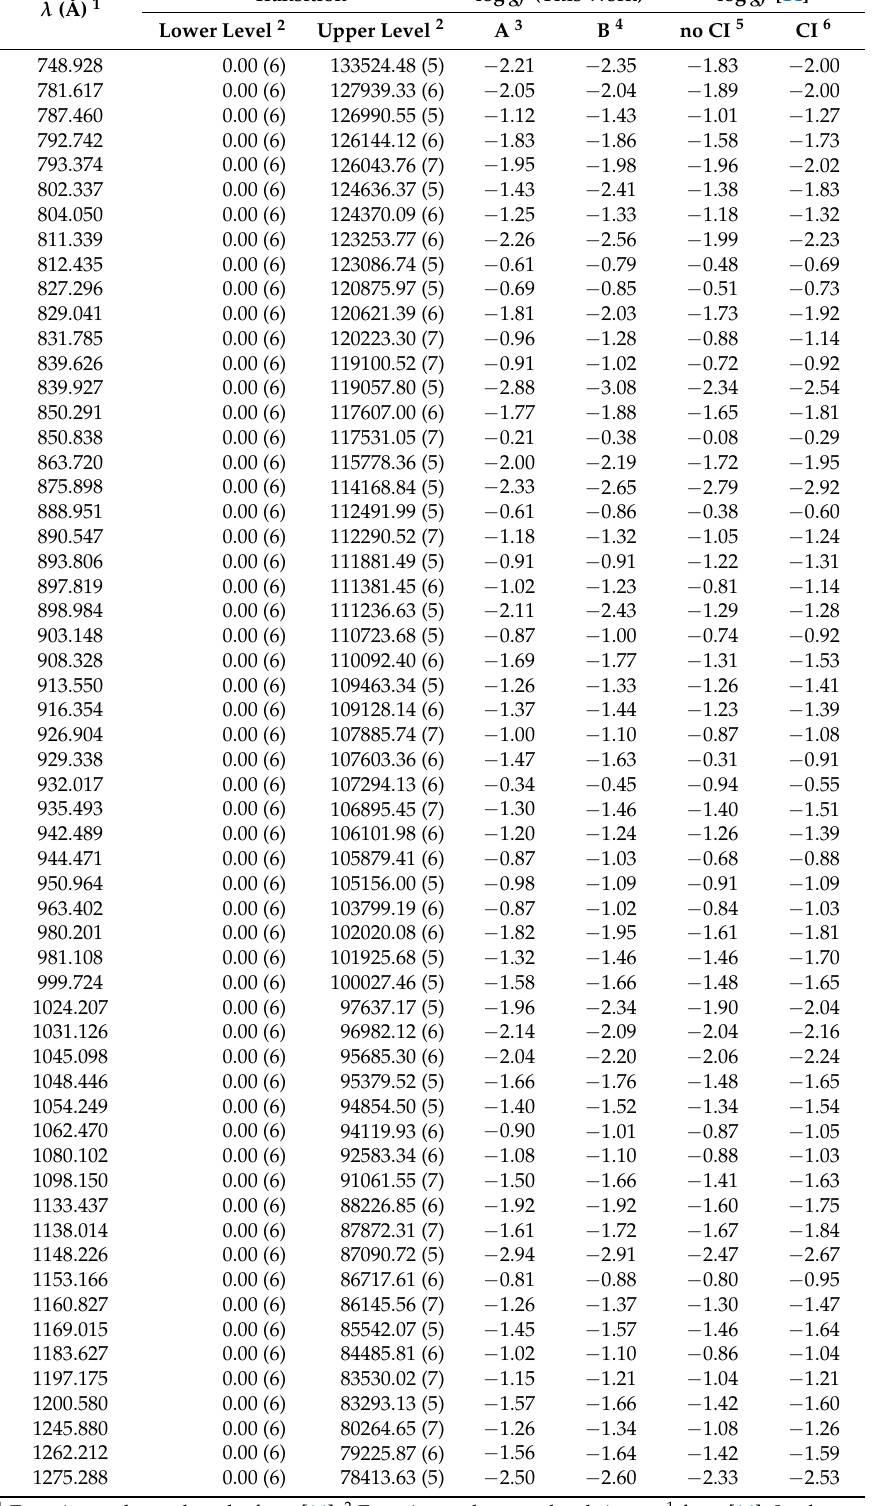
Table 1. Calculated oscillator strengths (log gf ) for transitions involving the lower 4f 12 3 H 6 ground level to upper 4f 11 5d levels in Tm